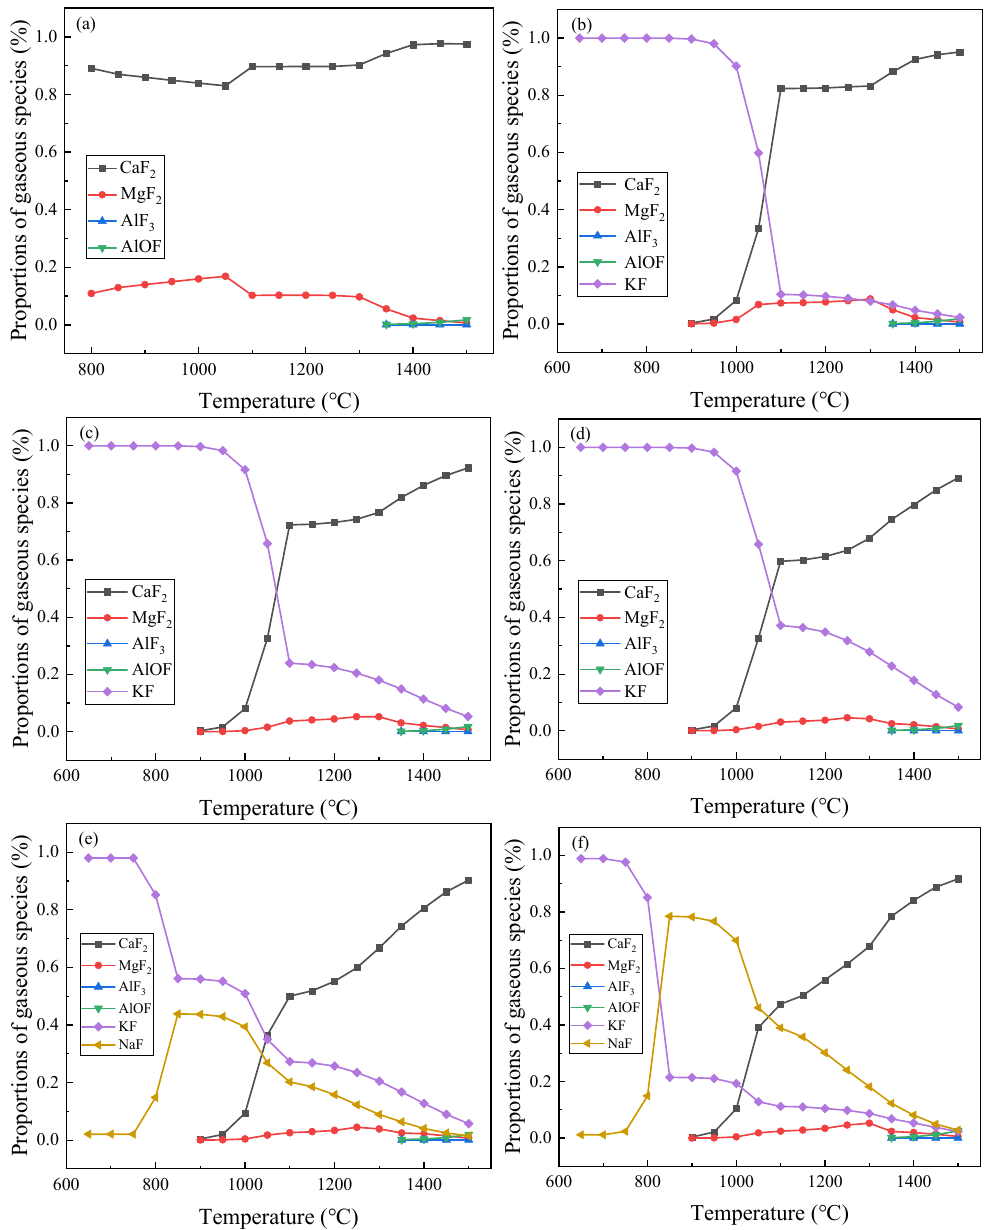
Figure 2. The proportions of main fluorine gases at different temperatures: ( a ) A, ( b ) K1, ( c ) K2, ( d ) K3, ( e ) K4, ( f ) K5.